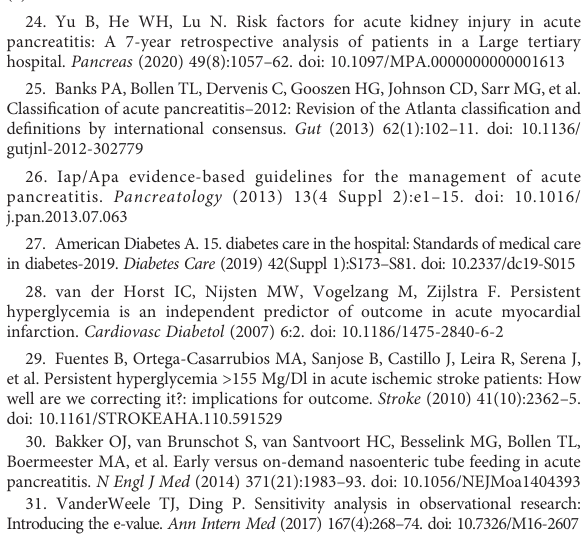
SUPPLEMENTARY FIGURE 1 Patient selection fl ow chart. (A) Chengdu cohort. (B) Nanchang cohort. AP, acute pancreatitis; CP, chronic pancreatitis.